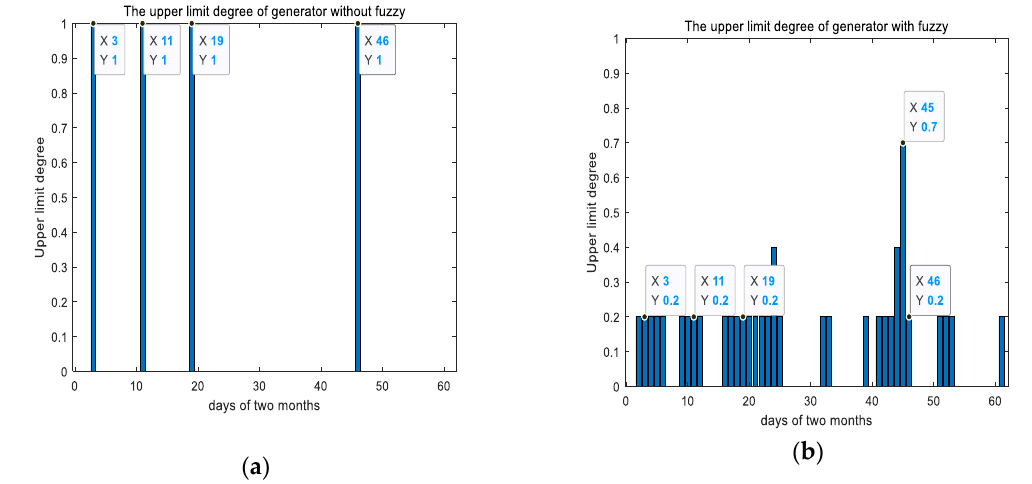
Figure 10. Limitation level comparison with ( a ) fuzzy inference and ( b ) without fuzzy.